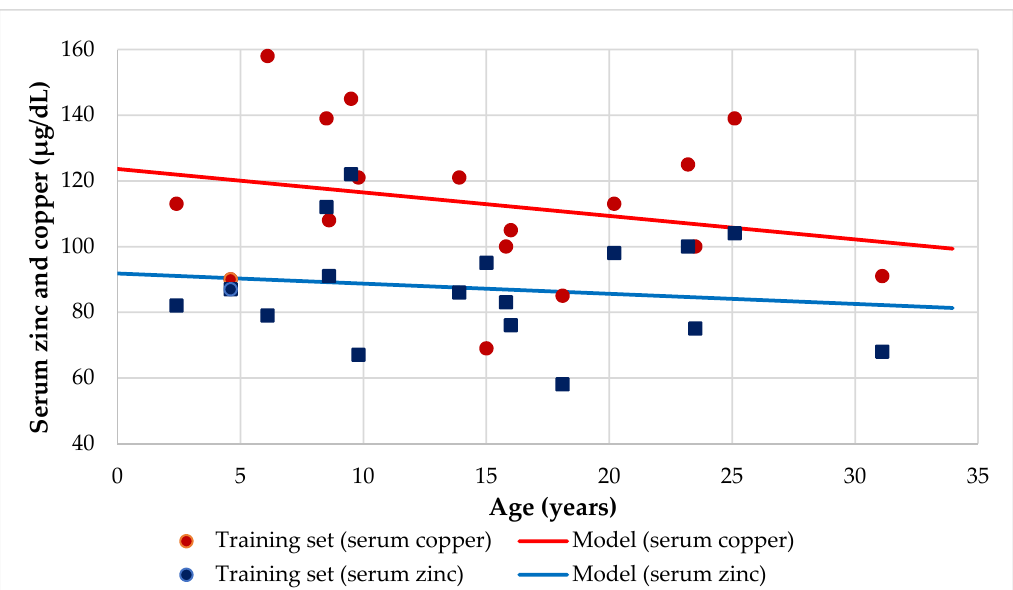
Figure 2. Regression serum copper and zinc ( μ g/dL) by age.